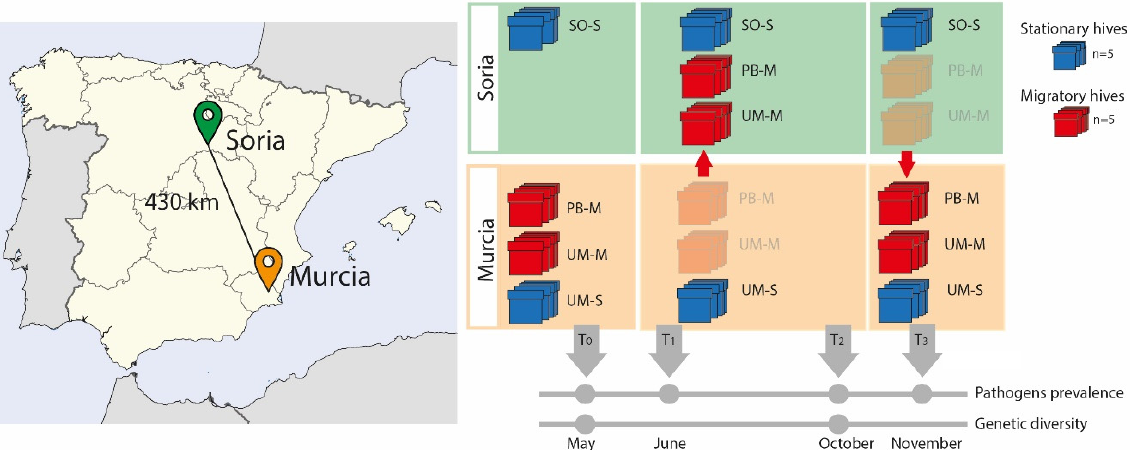
Figure 1. Graphic representation of the sample design. The map on the left shows the location of the two localities from where the hives were moved (Murcia) to the new location (Soria). On the right are representations of the two types of hives sampled (red = migratory, blue = stationary) and the timeline indicating the months in which samples were taken for the different analyses. (UM means Murcia, PB is professional beekeeper, SO is Soria, M = migratory, S = stationary).